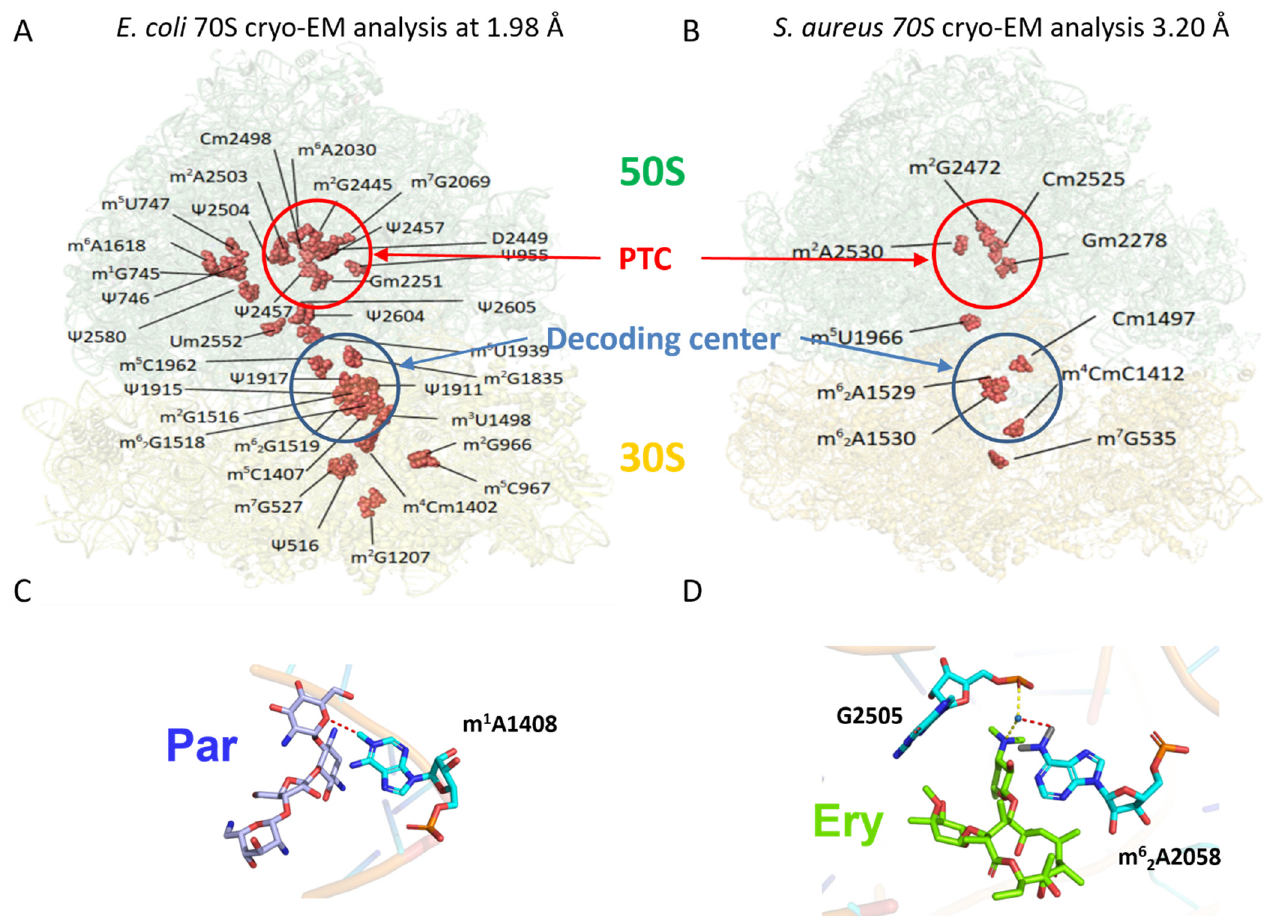
Figure 1. Natural ribosomal RNA modifications and additional modifications implicated in antibiotic resistance mechanisms as visualized by structural analyses. ( A ) Cryo-EM structure at 1.98 Å of E. coli 70S ribosome (pdb file 7K00). 11 and 24 RNA modifications (red spheres) could be visualized in the 30S (16S rRNA) and 50S (23S rRNA) subunits, respectively [88]. ( B ) Cryo-EM structure at 3.20 Å of S. aureus 70S ribosome (pdb file 6YEF). The limited resolution allowed the visualization of 4 modifications in the 16S rRNA and 6 in 23S rRNA [89]. PTC, Peptidyl Transferase Center on the large 50S subunit. ( C ) Mechanism of aminoglycoside (Par, paromomycin) resistance induced by methylation of A1408 (pdb file 5ZEJ [90]). The presence of the methyl group directly perturbs antibiotic interaction. ( D ) Mechanism of macrolide (Ery, erythromycin) resistance induced by dimethylation of A2058 (pdb file 6XHV [91]). The two methyl groups on A2058 prevent the coordination of a water molecule with G2505, which stabilizes erythromycin binding.